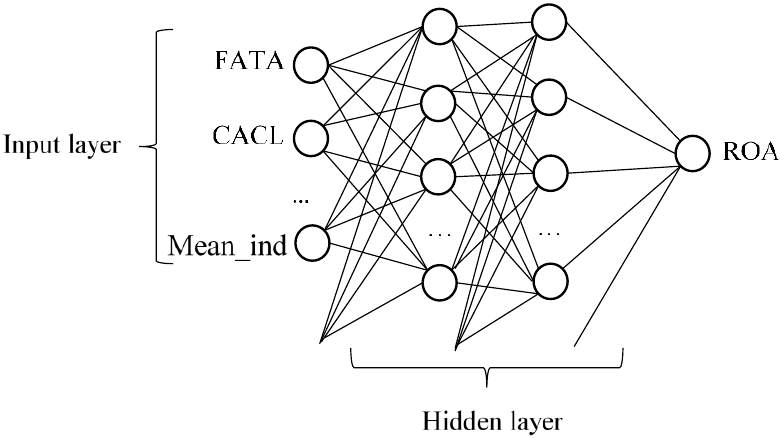
Figure 1. Structure of the deep neural network (DNN).